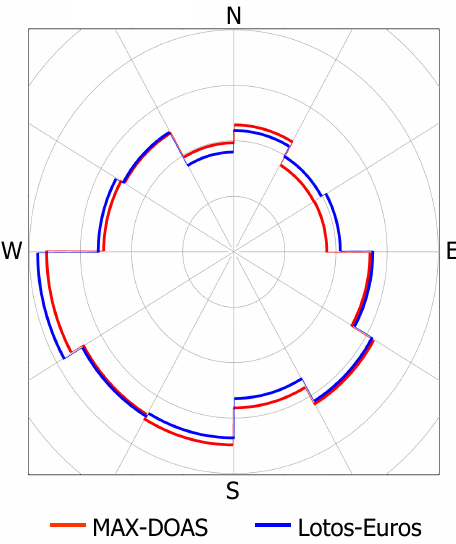
Figure 11. Average of modeled and observed tropospheric NO 2 col- umn for De Bilt, for 12 sectors of wind direction. The radius of the inner circle is 5 · 10 15 moleccm − 2 .